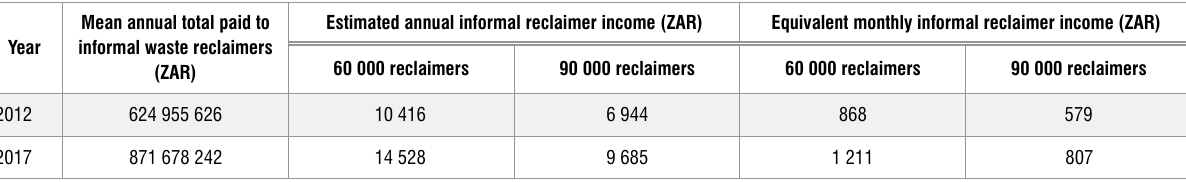
Estimated payment to informal reclaimers in South Africa via buy-back centres in 2017 Apparent Recyclable South African waste type